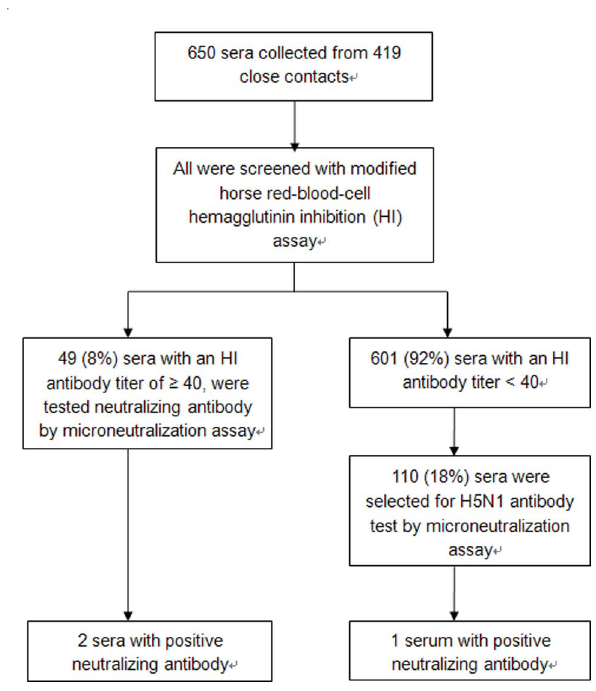
Figure 1. Flowchart of H5N1 serological testing for 419 close contacts exposed to HPAI H5N1 cases, China, 2005–2008.